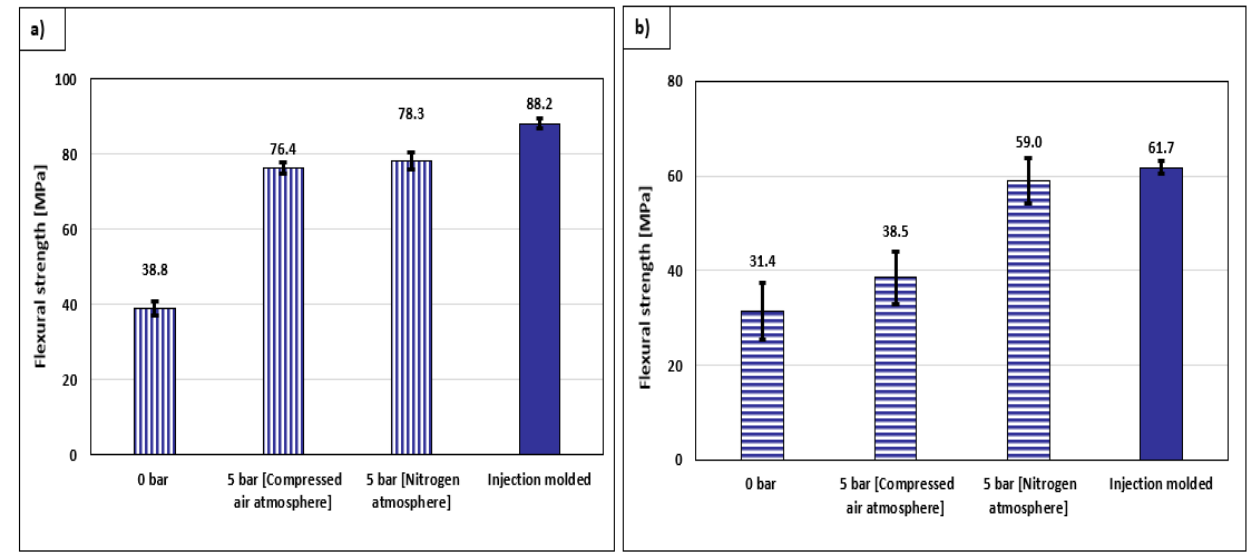
Figure 7. Flexural strength comparison of samples printed under different pressure settings longitu- dinally ( a ) and transversely ( b ).